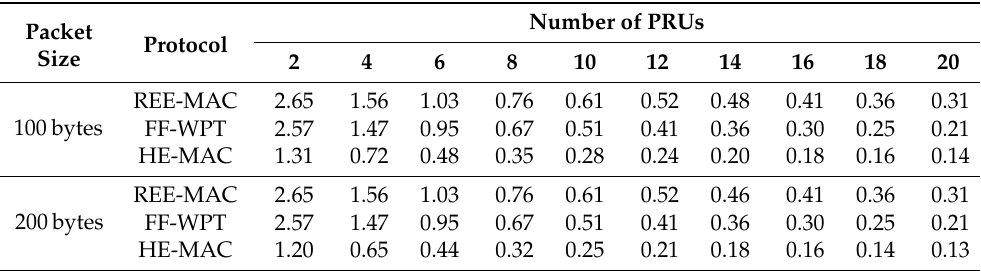
Table 2. Average harvested energy